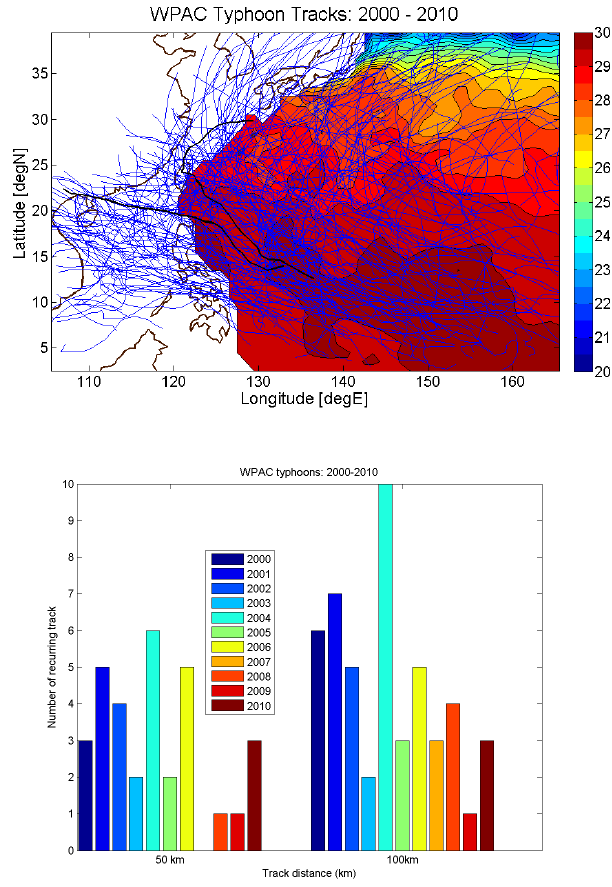
Figure 1. Climatology of 288 western Pacific typhoon tracks during year 2000 to 2010 and SST climatology for September (top panel) and the number of recurring tracks for each year (bottom panel). Two criteria of track radius, 50 and 100 km, were used to compute the statistics. On the top panel tracks of typhoons Hagupit and Jangmi are black solid lines.